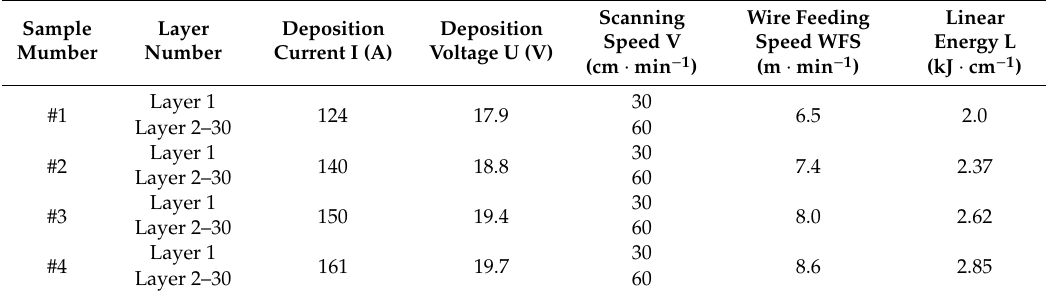
Table 2. Deposition process parameters.